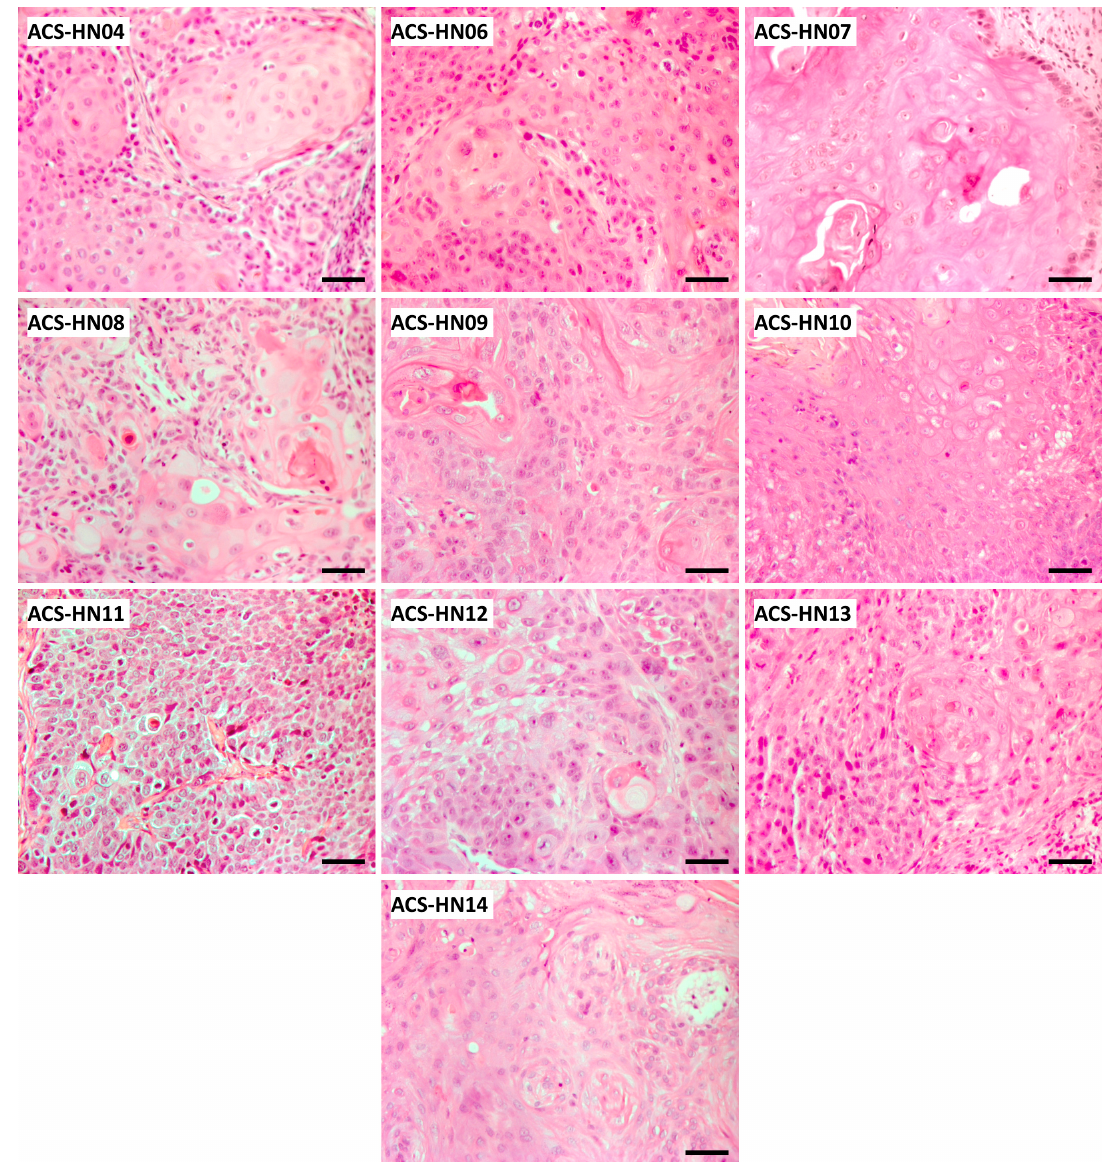
Figure 1. Histopathology of ten PDX models at second passage (P2). Scale bar = 50 µm.